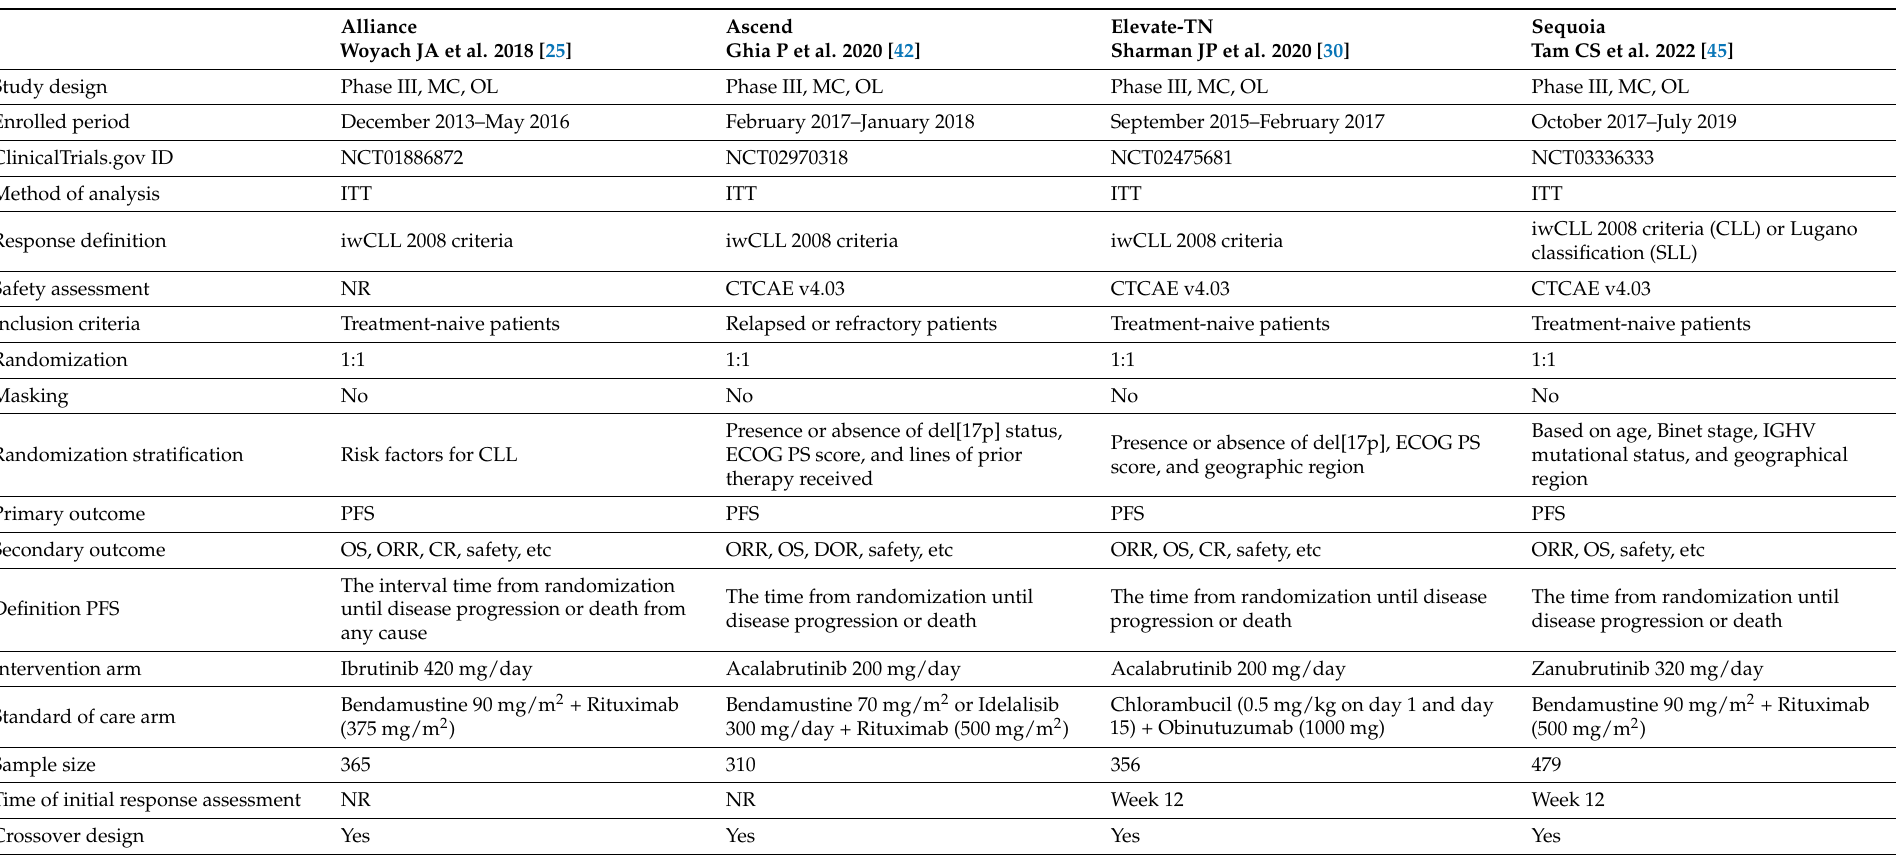
Table 1. Characteristics of the included randomized controlled